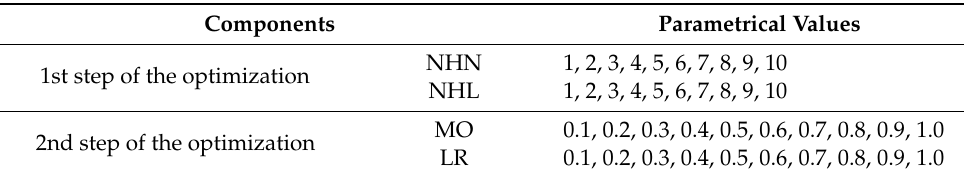
Table 2. Parametrically tested values of each ANN component.